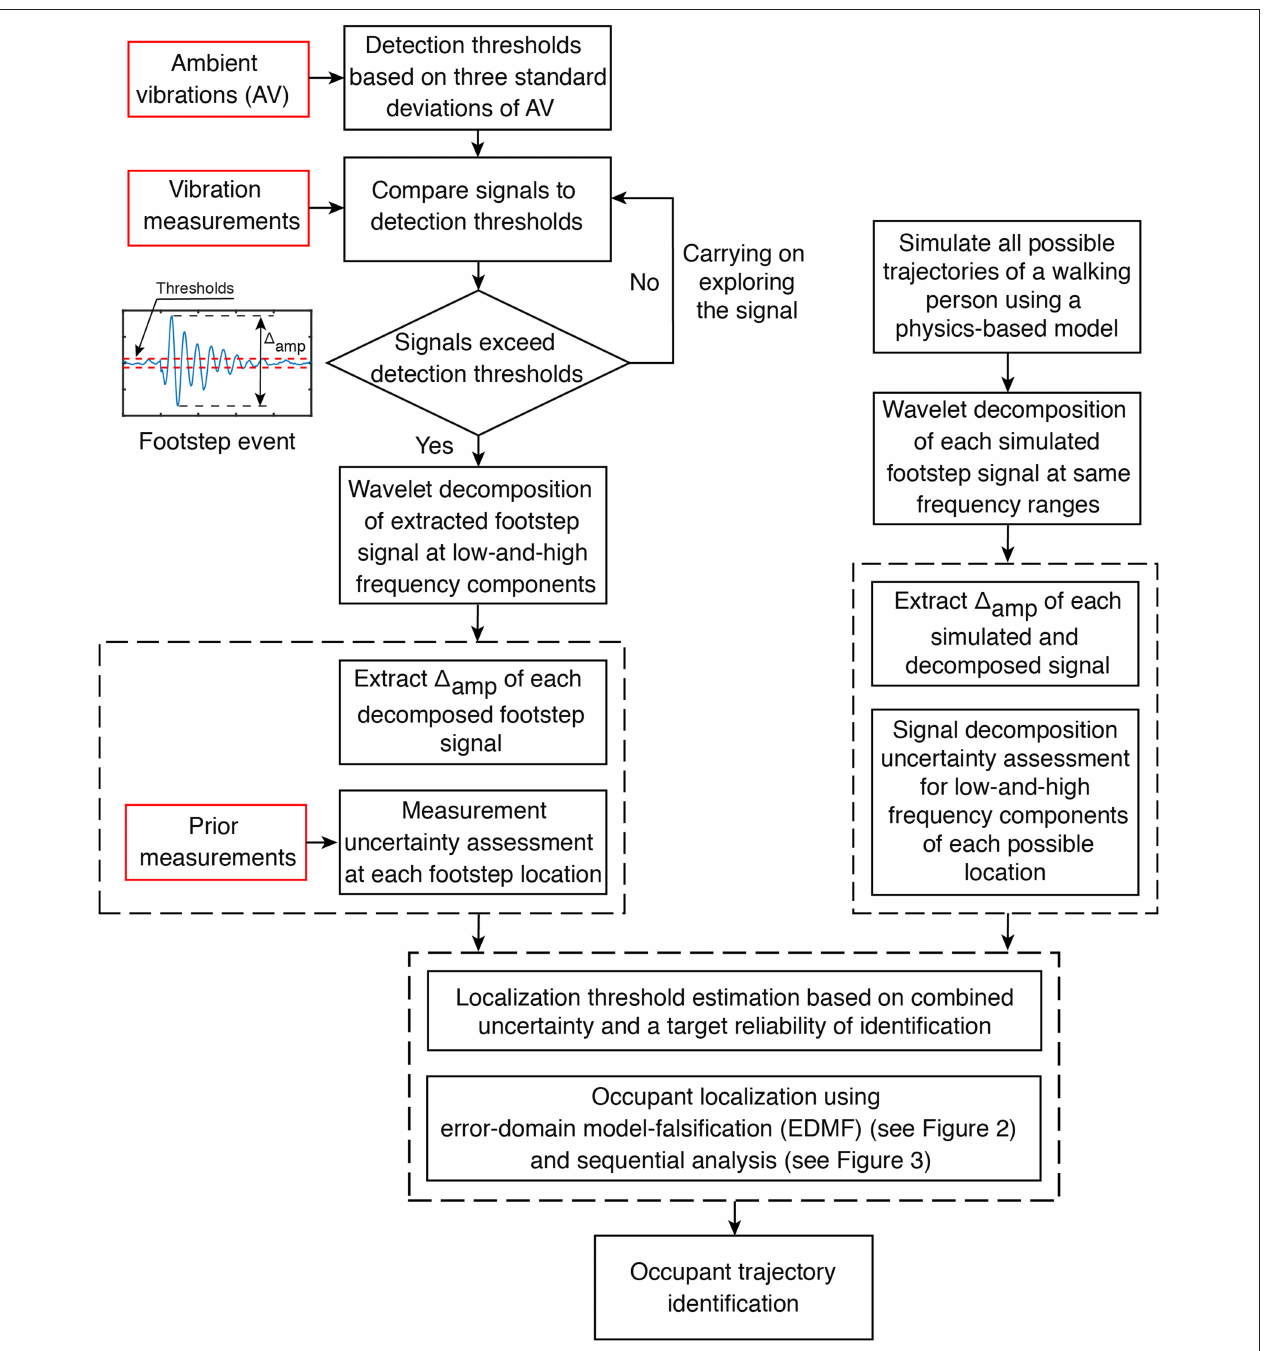
FIGURE 1 | Footstep events are detected when measured vibration amplitudes exceed detection thresholds. Simulations are compared with measurements using error-domain model-falsification (see section Error-Domain Model-Falsification). Candidate locations are then tested for sequential analysis (see section Sequential Footstep-Localization Analysis). Finally, trajectory identification process is carried out to infer occupant trajectories from candidate location sets.